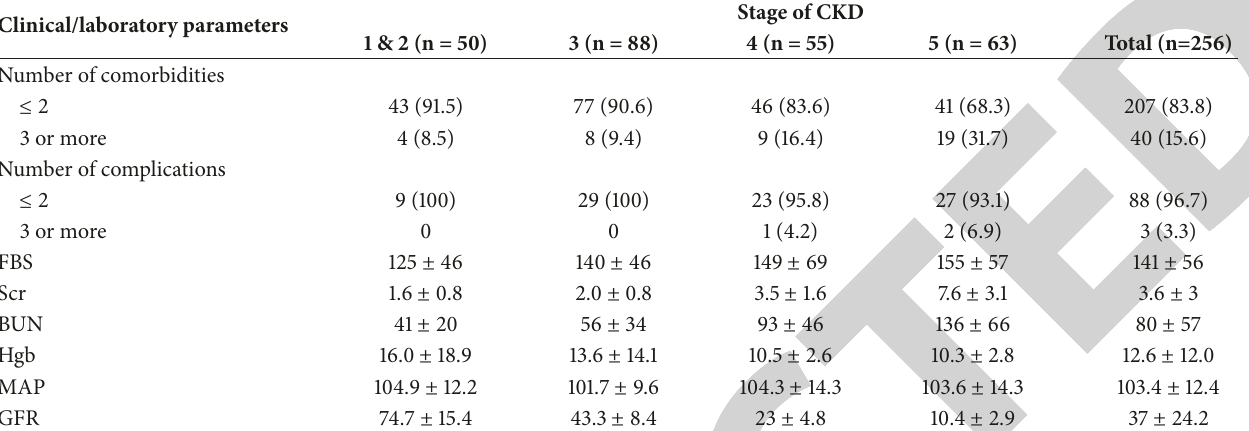
Table 2: Clinical and laboratory parameters according to the stage of chronic kidney disease patients attending the renal clinic of Tikur Anbessa Specialized Hospital. Clinical/laboratory parameters